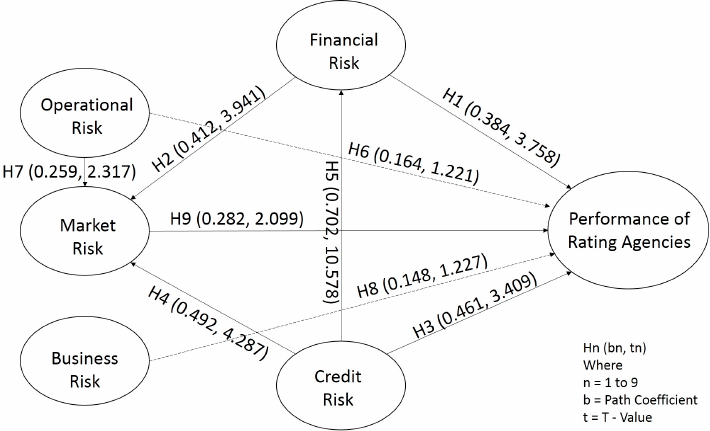
Figure 3. Results of the PLS Structural Model Analysis.